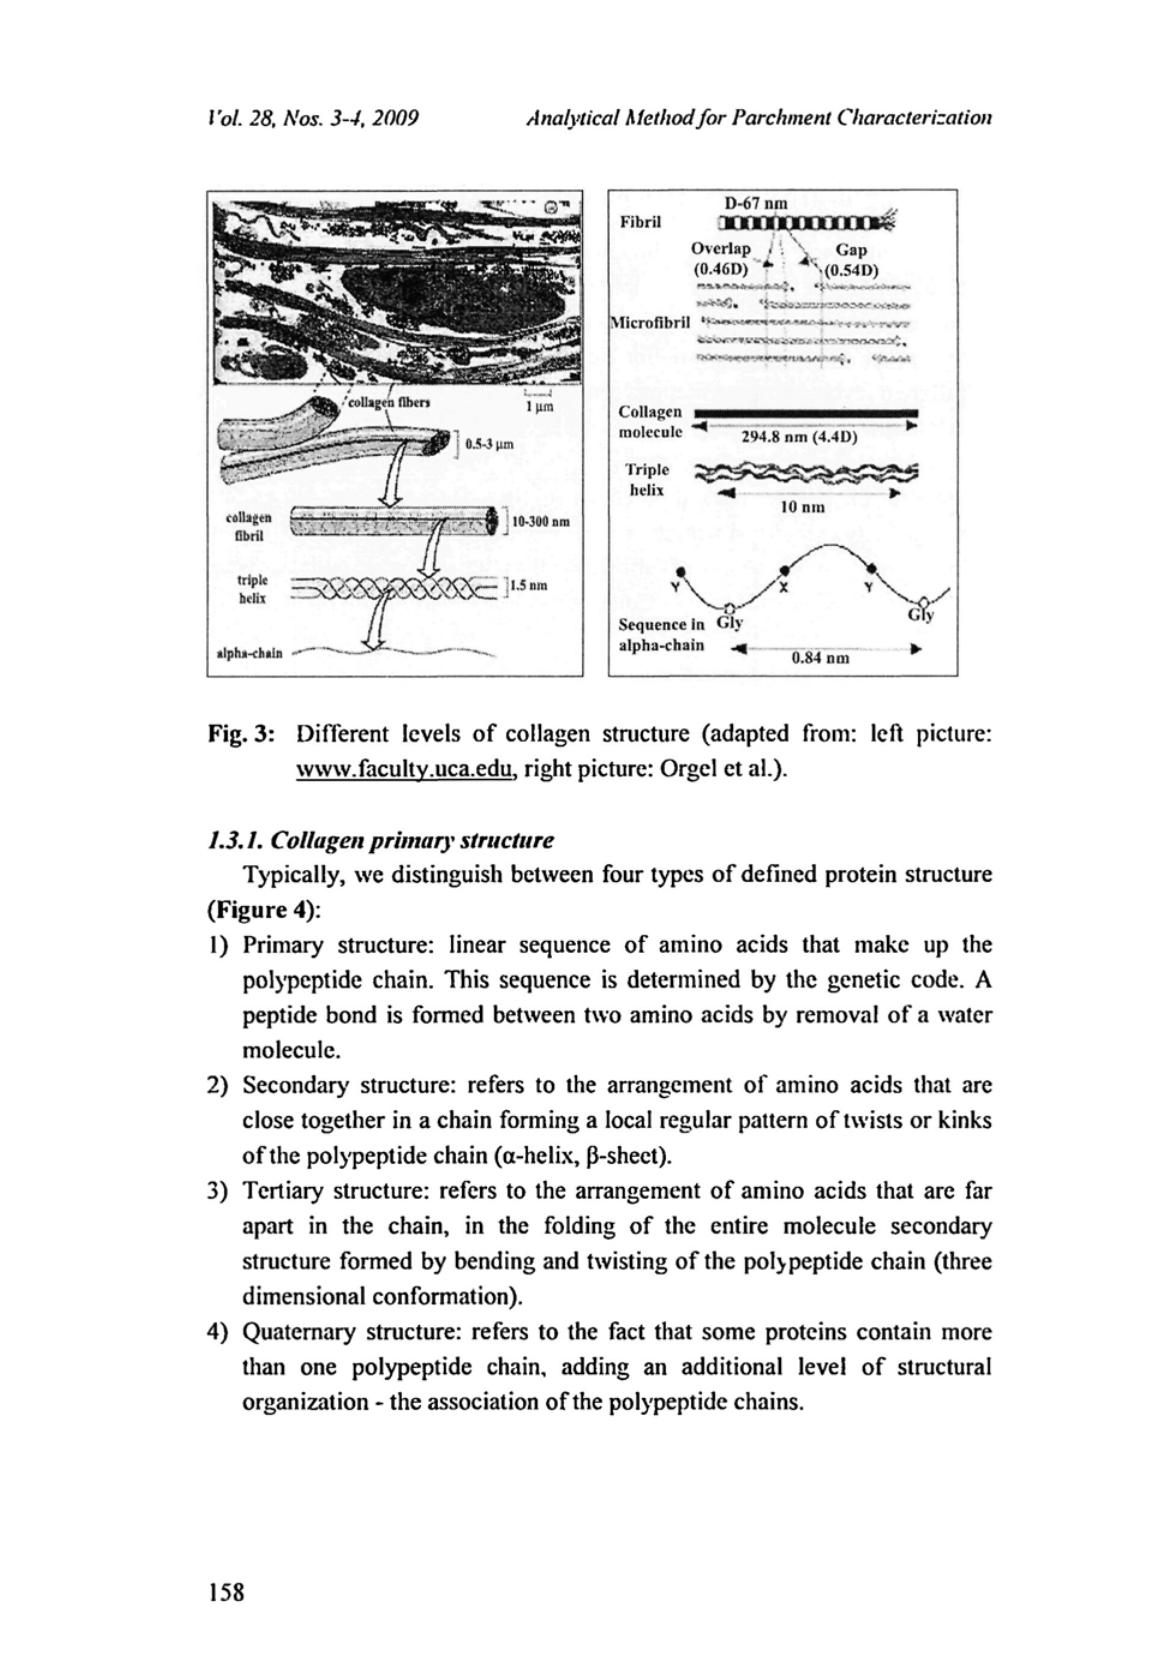
Fig. 3: Different levels of collagen structure (adapted from: left picture: www.facultv.uca.edu. right picture: Orgel et